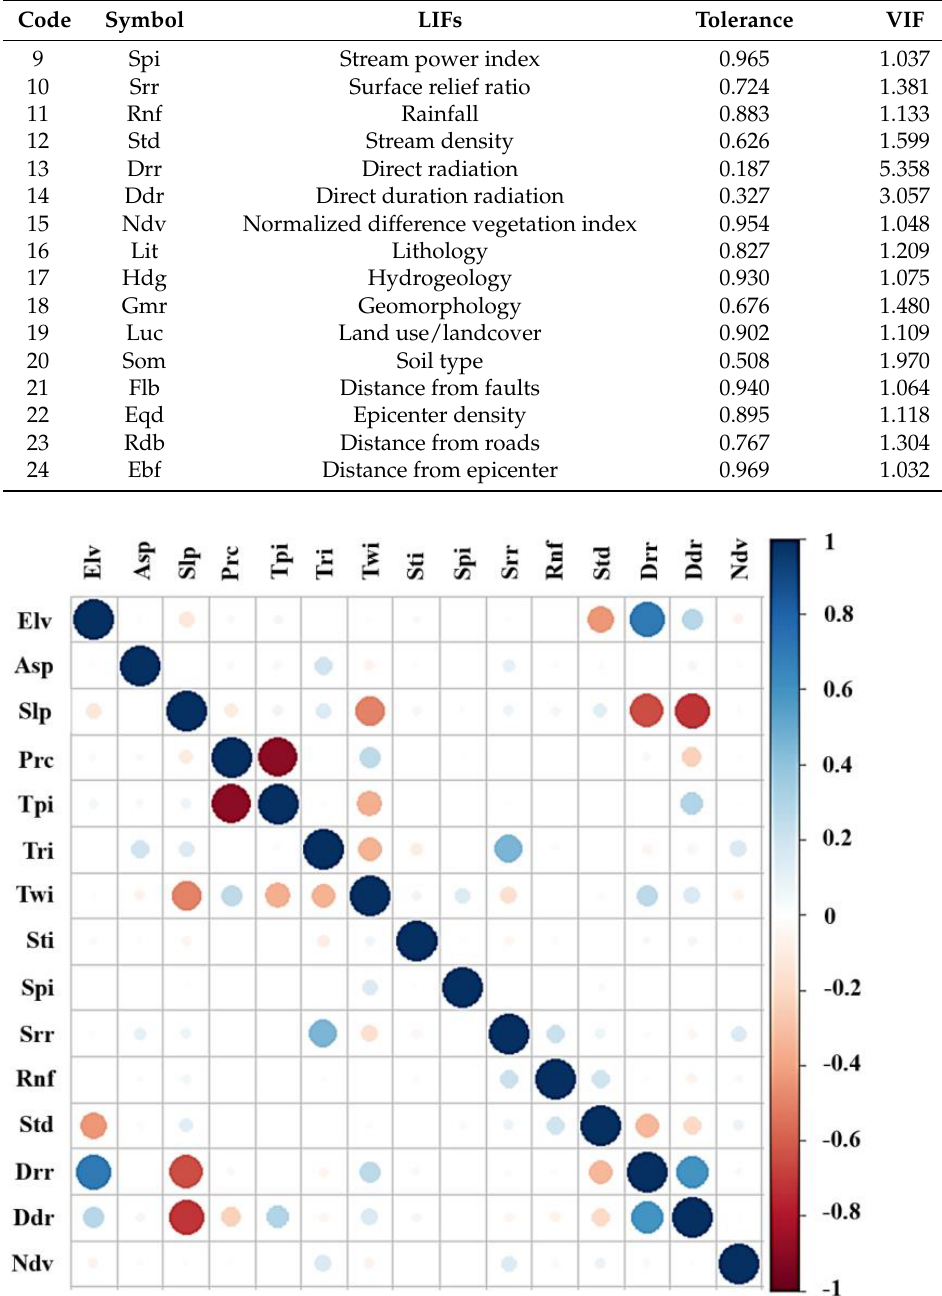
Figure 6. Pearson’s correlation plot of continuous LIFs. The nomenclature of symbols is provided in Table 3. Table 4. Relative importance (RI) of different LIFs derived from FS and EFS methods. LIFs are sorted in descending order based on their RI. The abbreviation of LIFs is provided in Table 3.